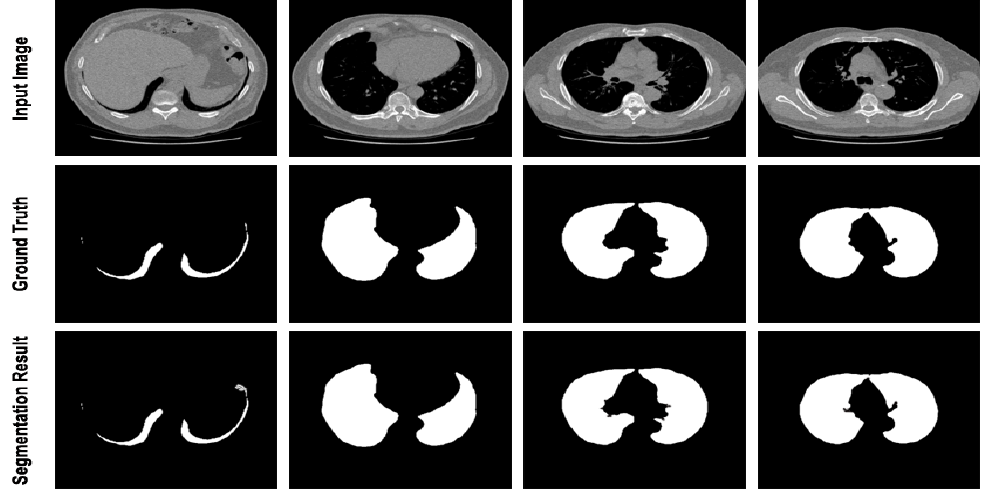
Figure 6. Segmentation results of the proposed method on lung dataset. The visualization shows that the proposed method learns the complex pattern of the lesion and precisely segments the abnormal